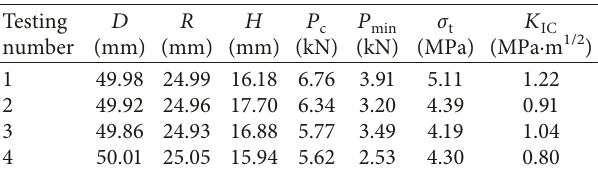
Figure 7: Load-displacement curves of the flattened Brazilian disk specimens. BT-1, BT-2, BT-3, and BT-4 denote the Brazilian disc test of specimens 1, 2, 3, and 4, respectively. Table 1: Tensile strength and fracture toughness of the red sandstone